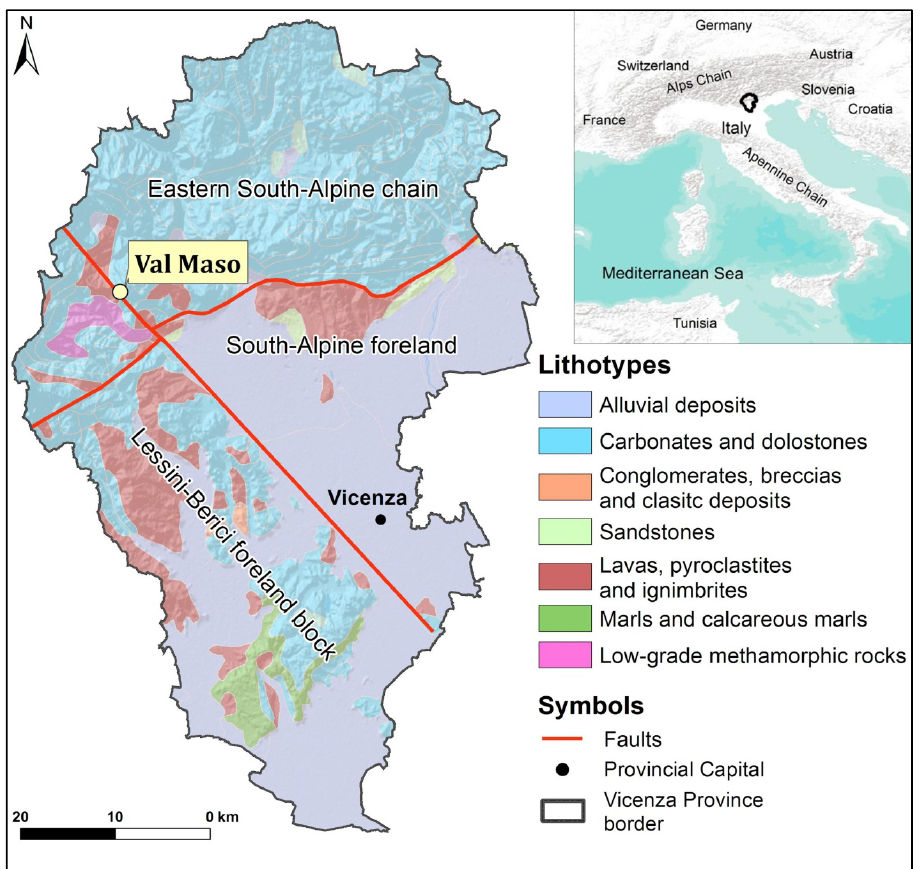
Fig. 1. Location of the Val di Maso landslide in the geological context of the Vicenza Province (Veneto region, Italy).